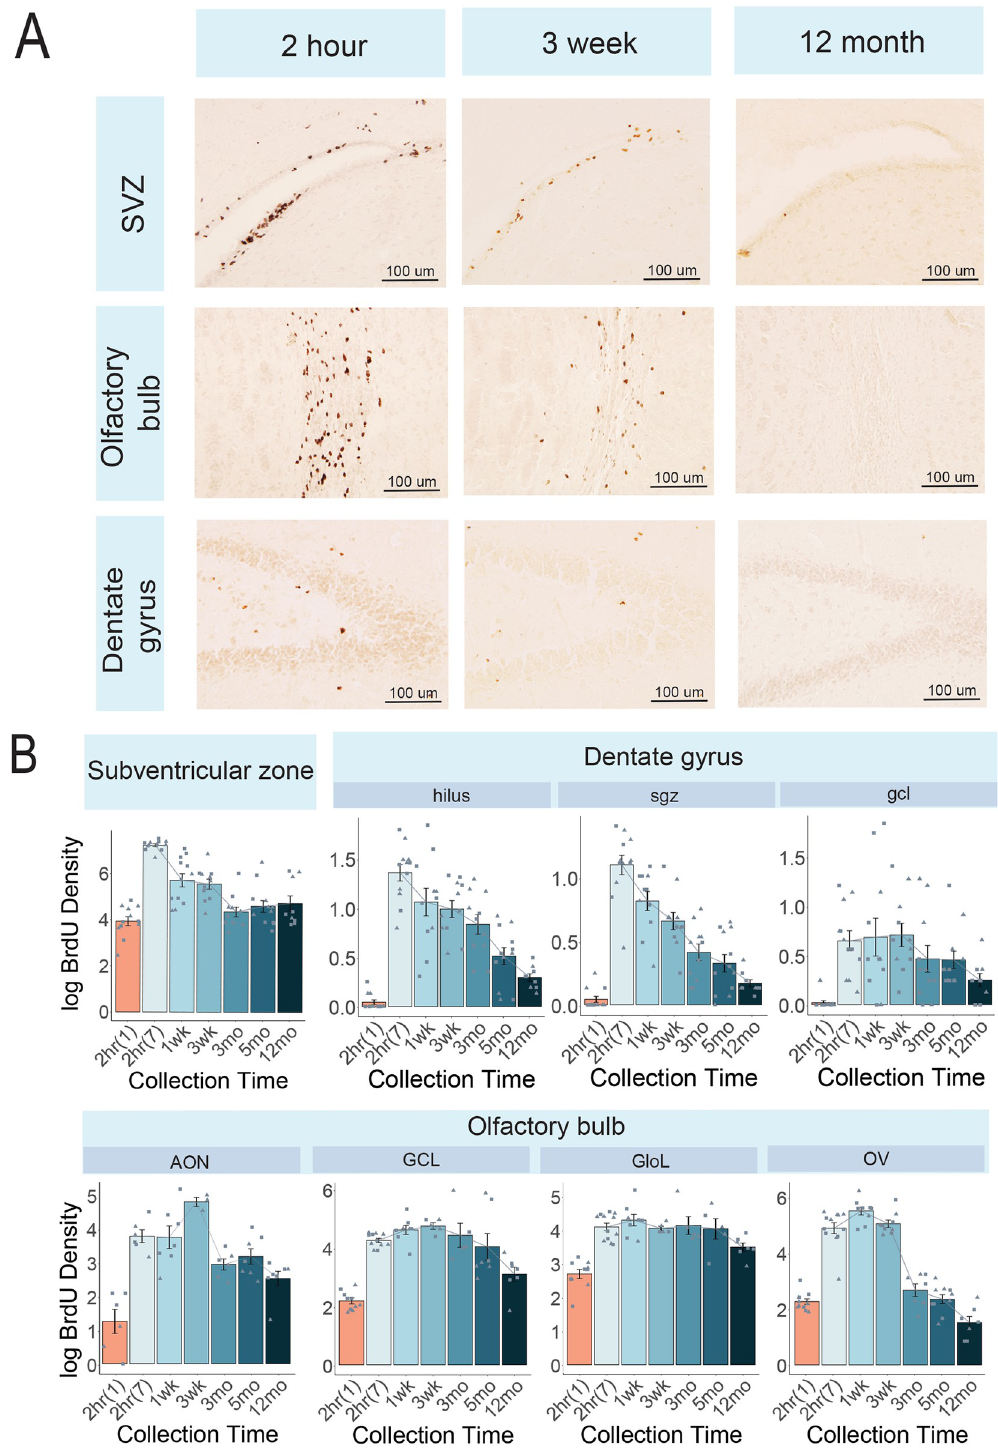
Fig 1. Cell proliferation in canonical neurogenic niches. A) Photomicrographs of the subventricular zone (SVZ), olfactory bulb, and dentate gyrus at representative timepoints after the last of 7 BrdU injections: 2 hour, 3 week, and 12 month. B) Bar plots of density (+/- SEM) across timepoints in the subventricular zone and subregions of the olfactory bulb (anterior olfactory nucleus, AON; granule cell layer, GCL; glomerular layer, GloL; and olfactory ventricle, OV) and the dentate gyrus (hilus; sub-granular zone, sgz; granular cell layer, gcl). 2hr(1) = animals collected after a single injection and 2hr(7) = animals